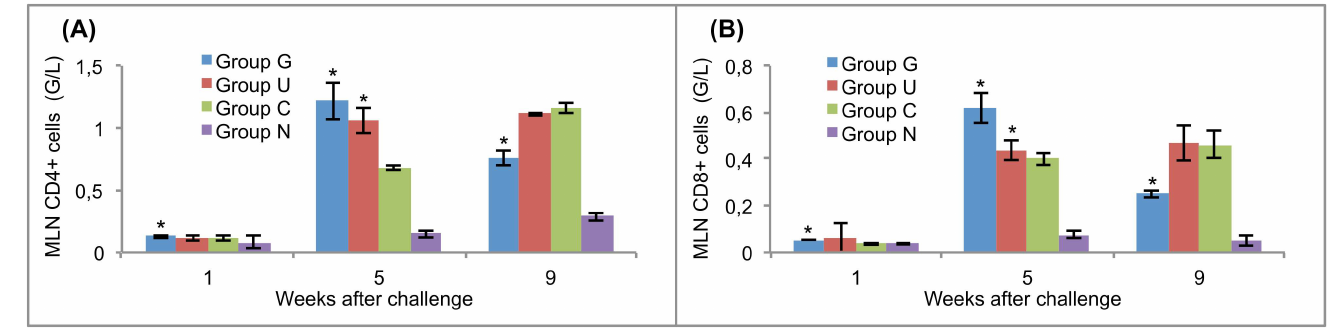
Fig 6. T lymphocyte responses in the mesenteric lymph nodes of vaccinated and control rats to challenge infections. (A) CD4+ cells. (B) CD8 + cells. Group G–Lyophilised lettuce expressingthe mature CPFhW enzyme flanked by Gly-rich linkers; Group U–Lyophilised lettuce expressingthe mature CPFhW protein fused with ubiquitin;Group C–Lyophilised control lettuce; Group N–None. At each timepointfour rats from each group were euthanised and dissected. * Indicatessignificantly increasednumbers of cells ( p < 0.05). Error bars indicatestandard